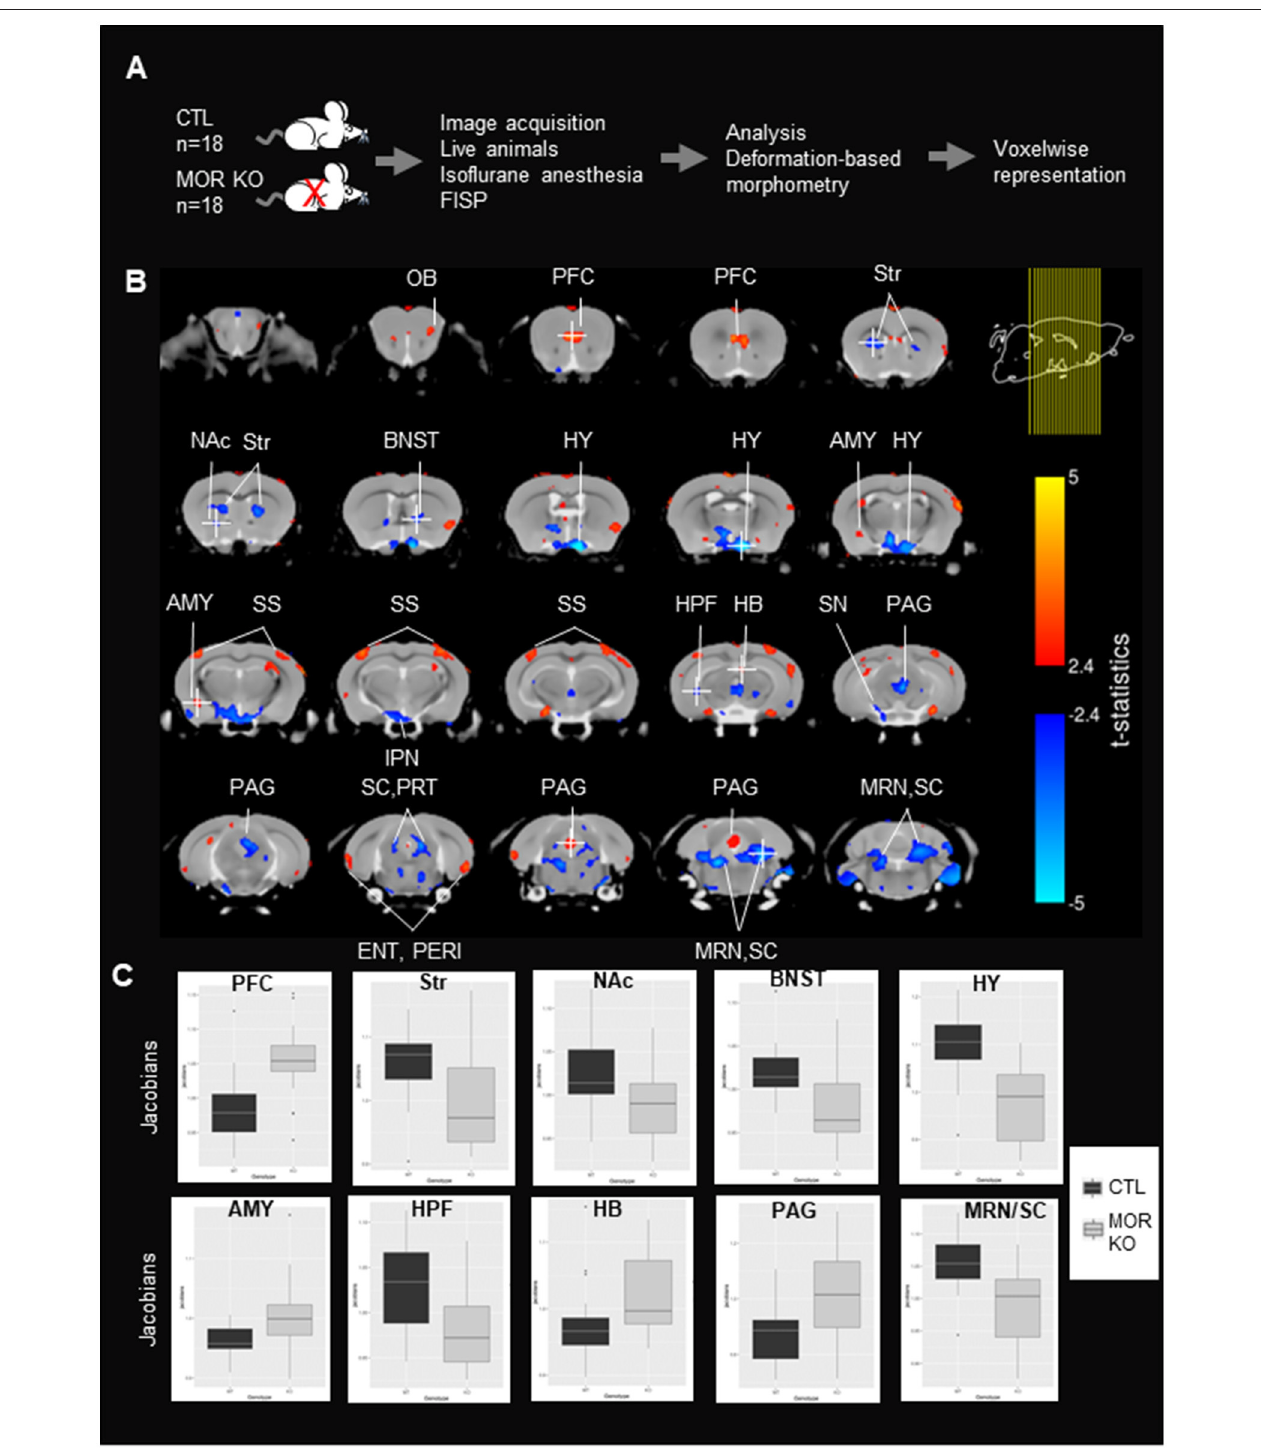
FIGURE 1 | Local volumes significantly differ between controls (CTLs) and MOR Knockout (KO) mice. (A) Experimental timeline. Experiment was performed in CTLs and MOR KO groups ( n = 18). MRI images were scanned following true-FISP sequences in live animals under isoflurane anesthesia. Anatomical differences in MOR KO animals were calculated using the deformation-based morphometry (DBM) and are represented voxelwise. (B) Significant anatomical differences ( t-statistic , p < 0.05 and FDR correction) between CTLs and MOR KO represented on a coronal. Coronal slices are represented from anterior to posterior. Right top corner shows